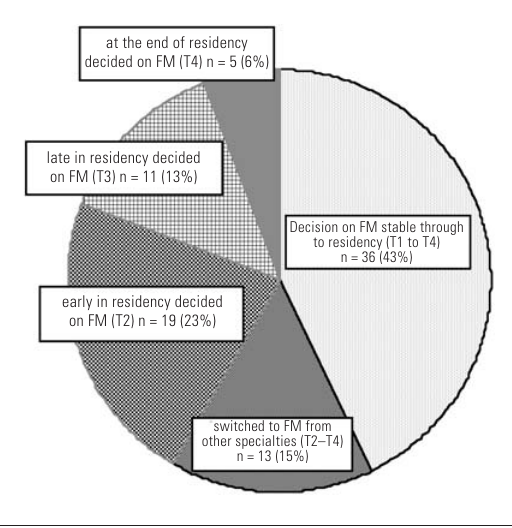
Stability in career choice of future family physicians from medical school through to residency (n = 84).